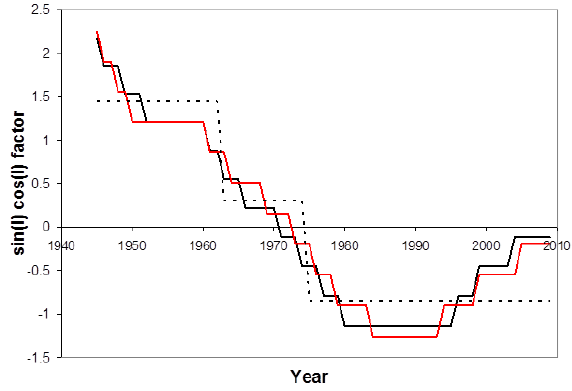
Figure 3. Standardized sin(I) cos(I) factor estimated with International Geomagnetic Reference Field (IGRF) model (http://ccmc.gsfc.nasa. gov/modelweb/models/igrf_vitmo.php) for Brisbaen (black solid line), Canberra (red solid line) and Christchurch (dashed black